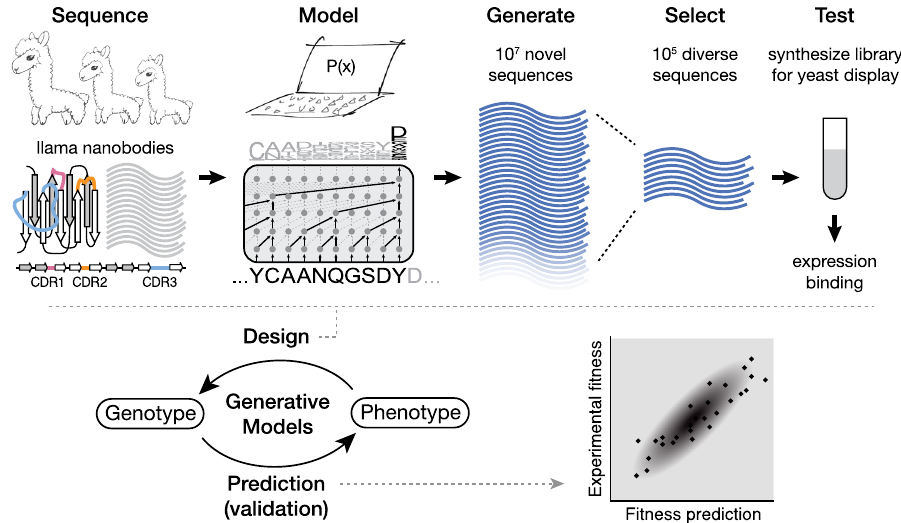
Fig. 1 Autoregressive models of biological sequences can learn the genotype-phenotype map for both prediction and design. From natural sequences (gray) in a naïve llama repertoire 57 , the autoregressive model can learn functional constraints by predicting the likelihood of each residue in the sequence conditioned on preceding residues. Nanobodies have three highly variable complementarity determining regions (CDR1, CDR2, and CDR3). We then use these constraints to generate millions of novel nanobody sequences (blue) — as many can be generated as desired. Of these designed sequences we select hundreds of thousands of diverse sequences, synthesize a library, and screen for expression and binding. We also validate the model on mutation effect prediction tasks of deep mutational scans including the effects of multiple insertions and deletions, and the thermostabilities of highly variable nanobody